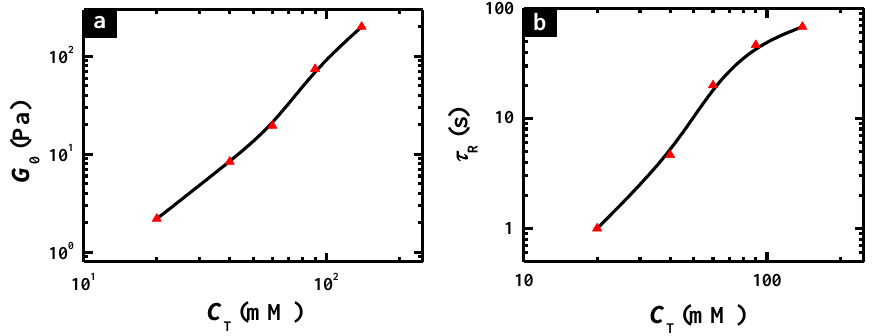
Figure 4. Steady ( a ) and dynamic ( b ) rheological properties of C 12 C 3 C 12 (SO 3 ) 2 solutions at different concentrations, and the total concentration is 20.0, 40.0, 60.0, 90.0 and 140.0 mM, respectively. Figure 5. Variation of G 0 ( a ) and τ R ( b ) as a function of C T for C 12 C 3 C 12 (SO 3 ) 2 solutions at pH 6.7.